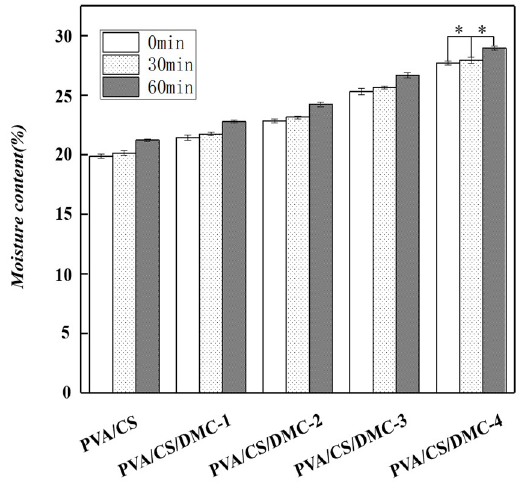
Figure 7. Moisture contents of different composite films in the case of varying ultrasonication time. ⁎ Values marking various superscripts for every parameter within the same ultrasound times differ noticeably ( p < 0.05).